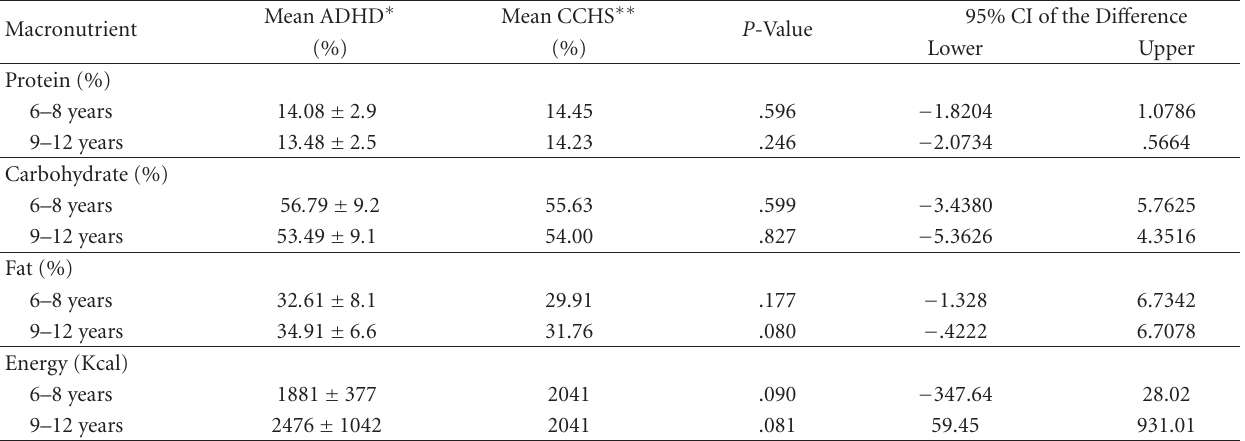
Table 1: Comparison of Macronutrient Distribution in the Diets of Children with ADHD with British Columbia aged 6–8 and 9–12 years.